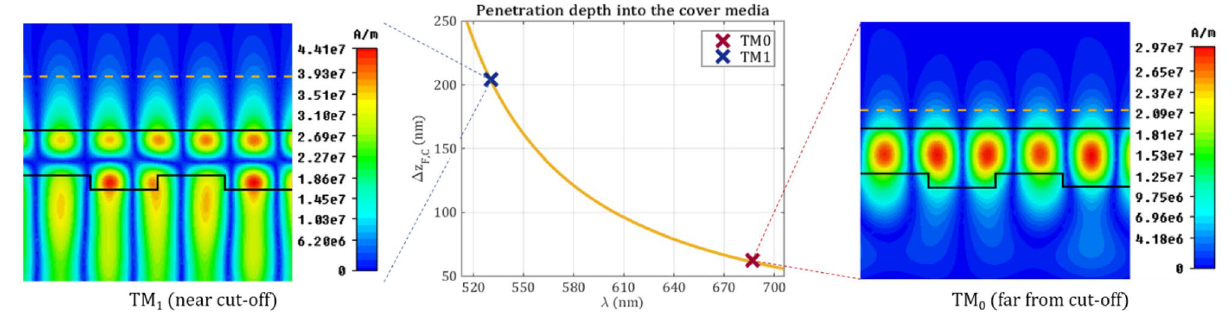
Figure 5. The penetration depth into the cover medium as a function of wavelength for d F = 185 nm and cover refractive index n C = 1.4 and with an incidence angle of 26°. The penetration depth of the TM 0 mode is 61 nm and of the TM 1 mode is 203 nm as indicated with the cross marks. These values are also visualized on the corresponding magnetic field distributions with orange dashed lines. The magnetic field distributions are calculated by CST Studio Suit 37 .